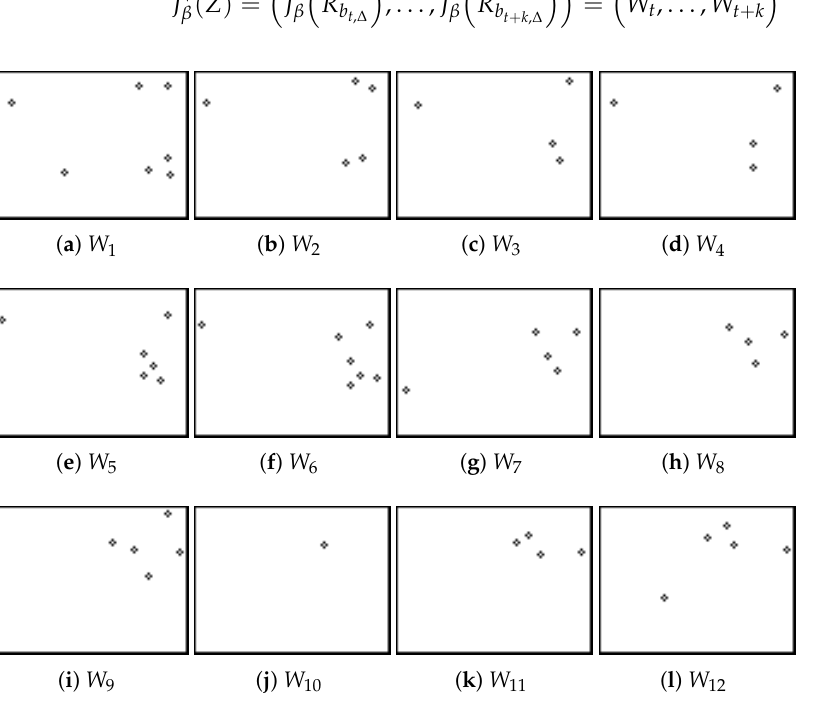
Figure 11. Motion frames W 1 to W 12 obtained from original frames F 1 to F 12 in Figure